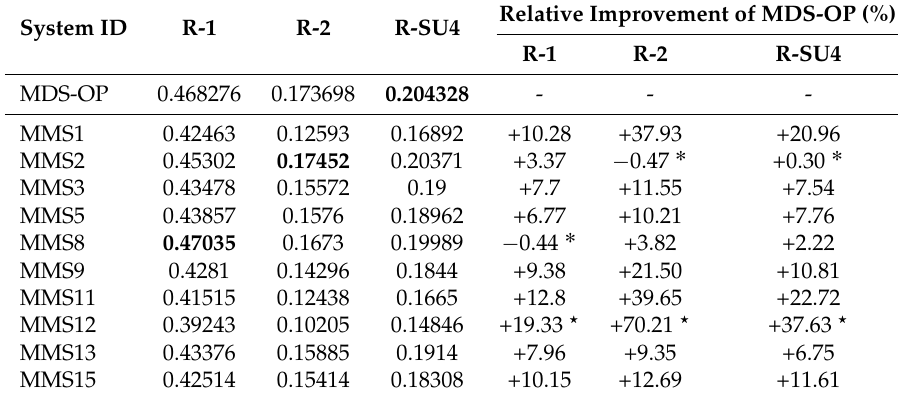
Table 5. F-measure scores of ROUGE-1, ROUGE-2, and ROUGE-SU4 MDS-OP and the participating systems on MultiLing 2015 (MMS task). The highest values are written in bold. The highest and the lowest improvements (%) of MDS-OP are indicated by ‹ and ˚ , respectively.